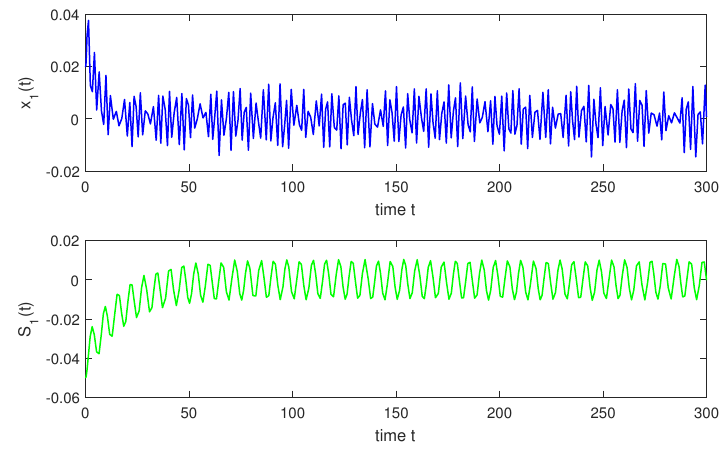
Figure 1. Continuous situation T = R : x 1 , S 1 with t .